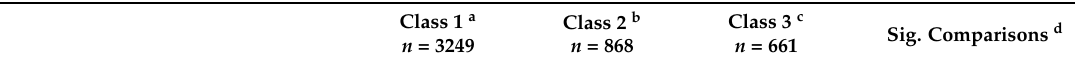
Sig. Comparisons